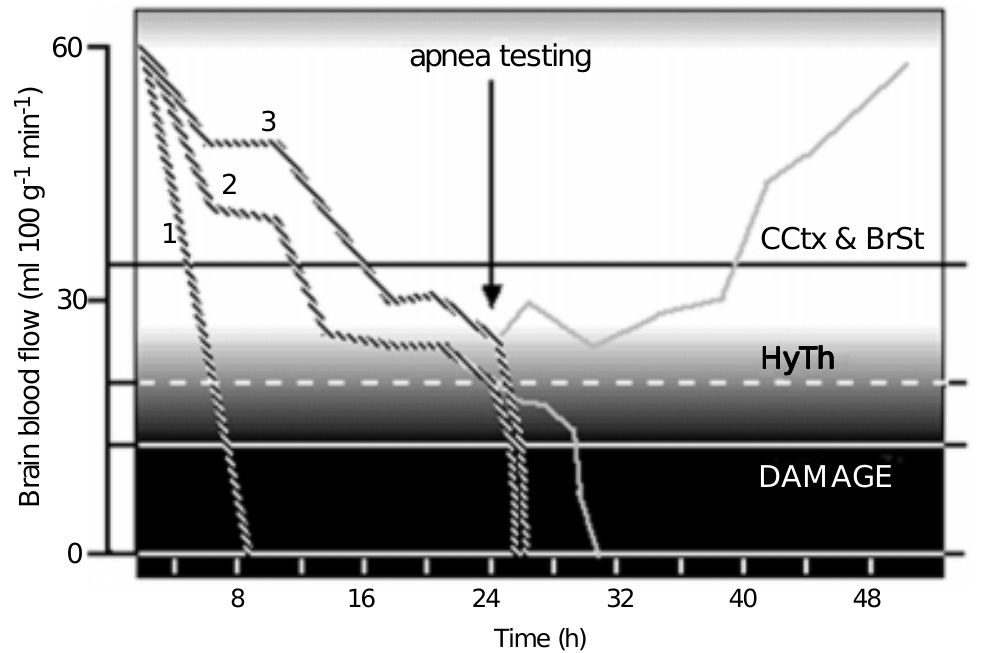
Figure 2 - Evolution of brain blood flow (BBF) in three hypo- thetical cases of intracranial hy- pertension: influence of hypo- tension induced by apnea test- ing at 24-h survival. Whilst BBF is unaffected in case 1, apnea testing hastens and sets the clinical outcome to irreversible brain damage in cases 2 and 3 by inducing collapse of intracra- nial vessels. For abbreviations see legend to Figure